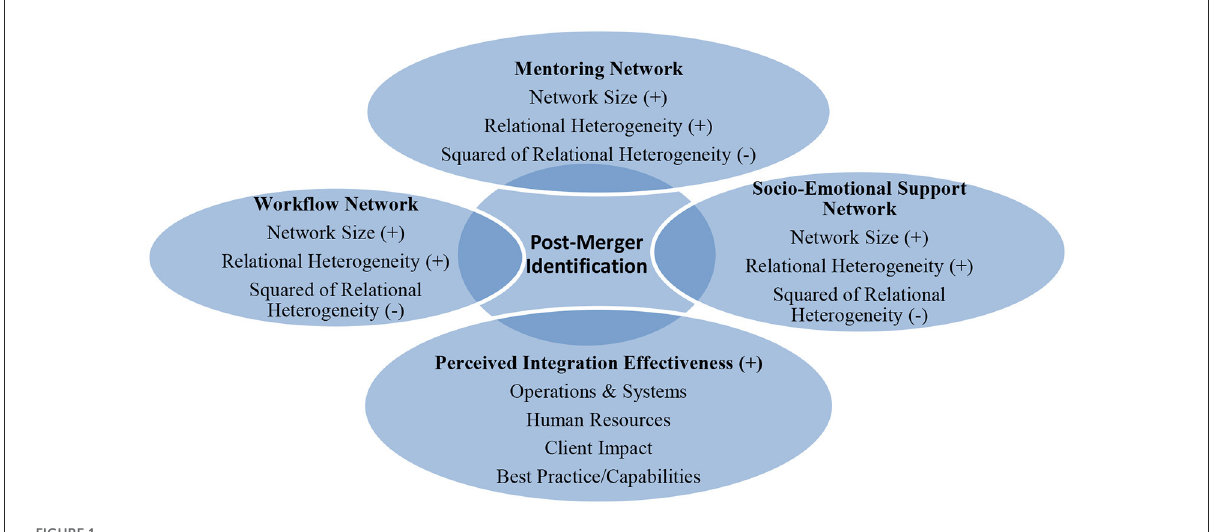
FIGURE1 Employees’ Identification with a merged